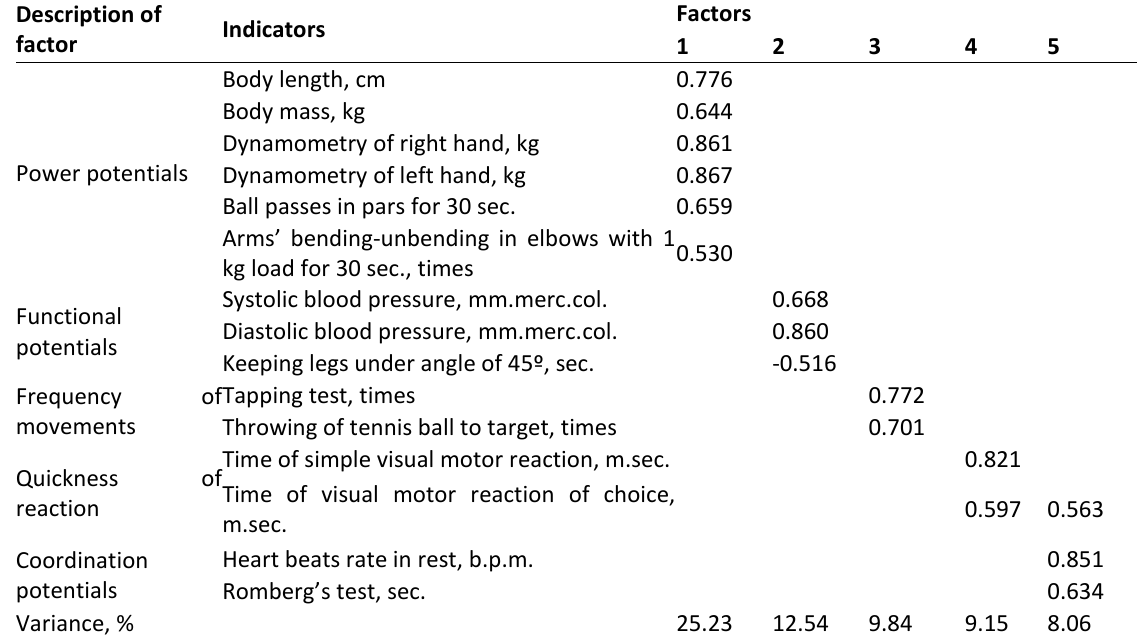
Table 1. Matrix of components in factorial analysis of complex testing indicators of physical